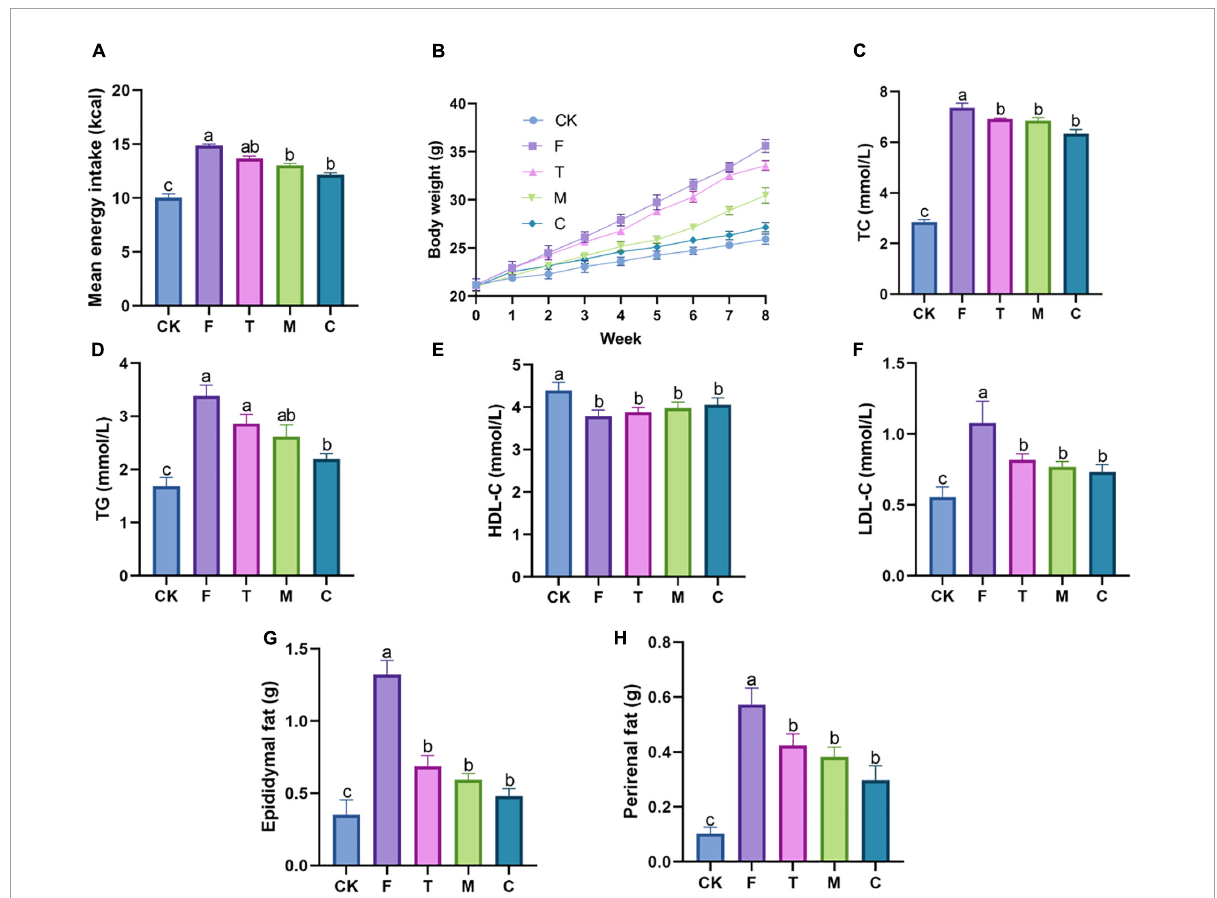
FIGURE1 Different qualities of green tea powder reduced body weight and improved dyslipidemia. (A) Mean energy intake. (B) Body weight variation trend. (C) Serum TC levels. (D) Serum TG levels. (E) Serum HDL-C levels. (F) Serum LDL-C levels. (G) Epididymal fat weight. (H) Perirenal fat weight. Different letters (a–c) showed significant difference ( p <